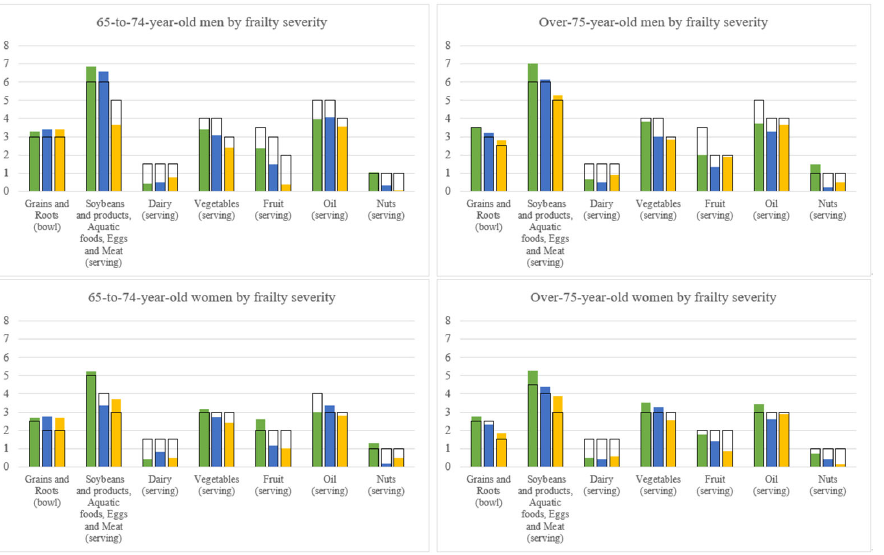
Figure 3. Comparing dietary intake levels of the six food groups with the Daily Food Guide of Taiwan among frailty severity groups by sex and age groups. Top: The dietary intakes of the six food groups by three frailty subgroups and by two age groups in men. Bottom: The dietary intakes of the six food groups by three frailty subgroups and by two age groups in women. The robust is in green, the pre ‐ frail is in blue, and the frail is in yellow. The blank bar ( □ ) indicates the recommended number of servings of the six major food groups by the Daily Food Guide of Taiwan according to the corresponding energy levels.